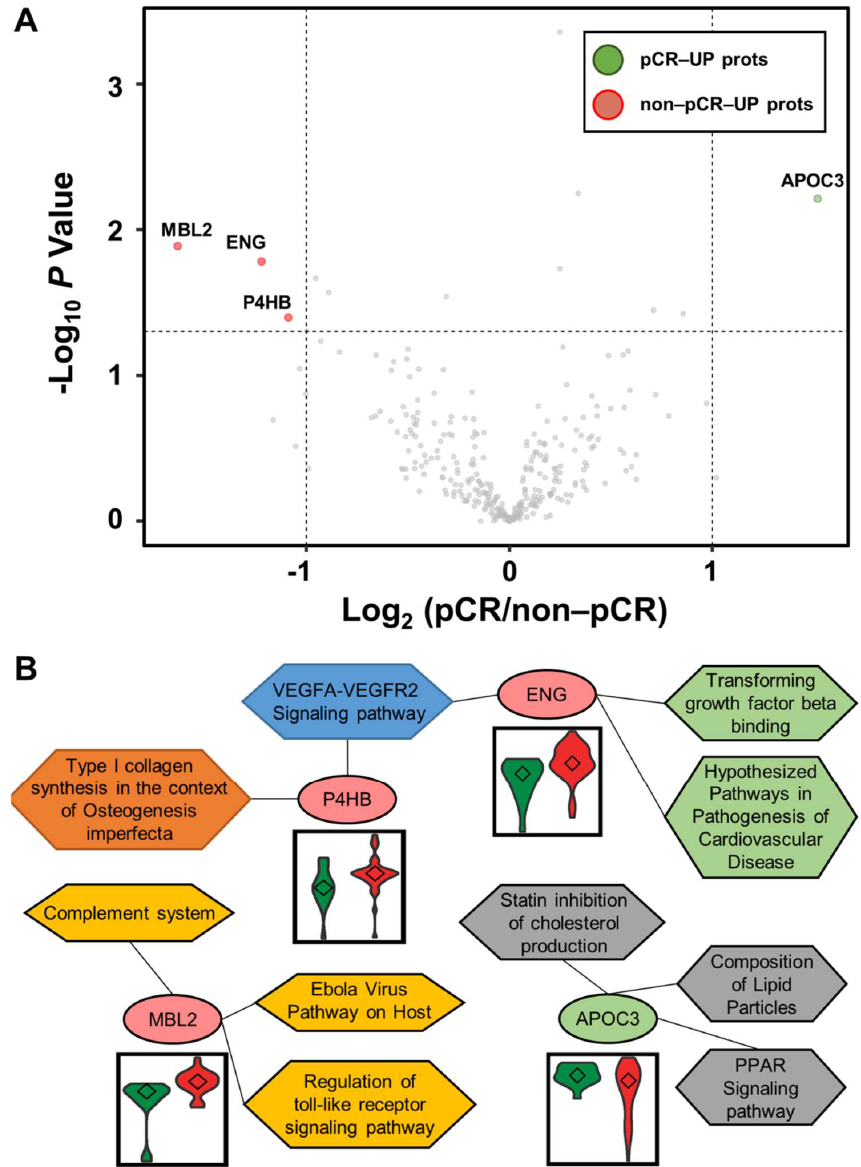
Figure 2. Volcano plot for DAPs altered by pathological complete response (pCR) and functional interpretation. ( A ) Log 2 fold changes and the corresponding p -values of all proteins between pCR group ( n = 15) and non-pCR group ( n = 36) are presented as volcano plot. Proteins upregulated with more than a twofold change with a p -value < 0.05 are depicted in red circles and those downregulated with identical fold change and p -value are in green circles. Gray circles show plasma proteins that did not show statistically significant differences. ( B ) Association between WikiPathways and proteins, and violin plots of the corresponding proteins between the two groups (pCR: green; non-pCR: red).